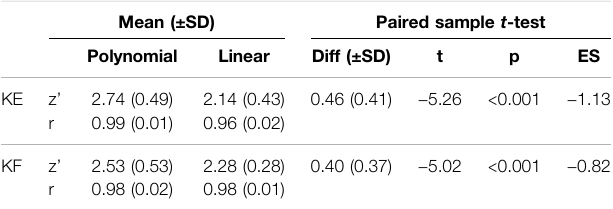
TABLE 1 | Differences between the fi t of 9-point methods to the KE and KF F-v data. Mean (±SD) Paired sample t -test